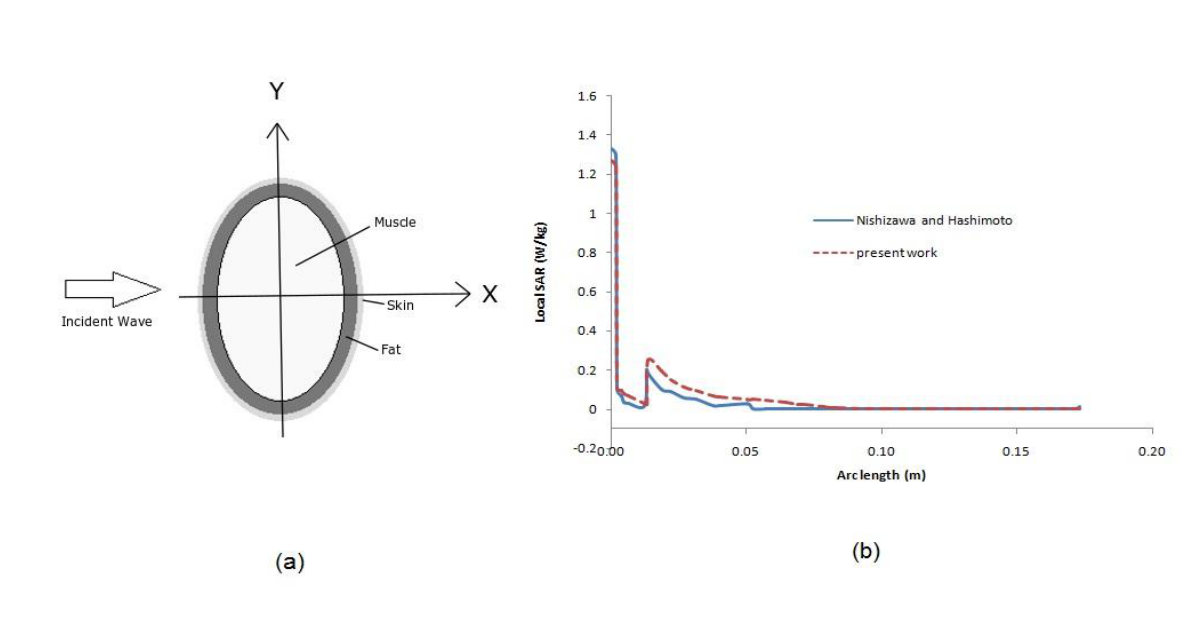
Figure 4: (a) 2-dimensional geometry for validation of model from Nishizawa and Hashimoto [39] (b) comparison of local SAR distribution calculated by present numerical simulation and that by Nishizawa and